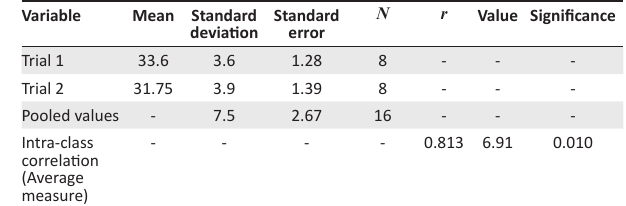
TABLE 3: Test–retest measurements.